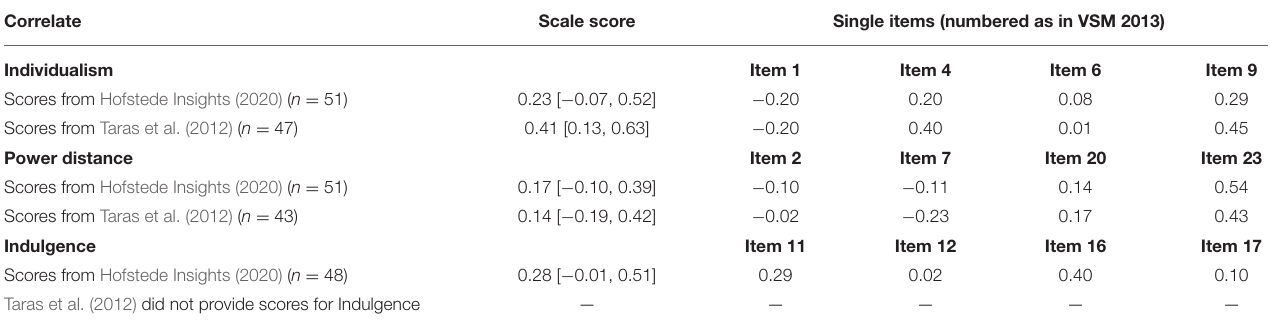
TABLE 3 | Pearson correlations between measures in this study and other measures of the cultural dimensions. Correlate Scale score Single items (numbered as in VSM 2013) Individualism Item 1 Item 4 Item